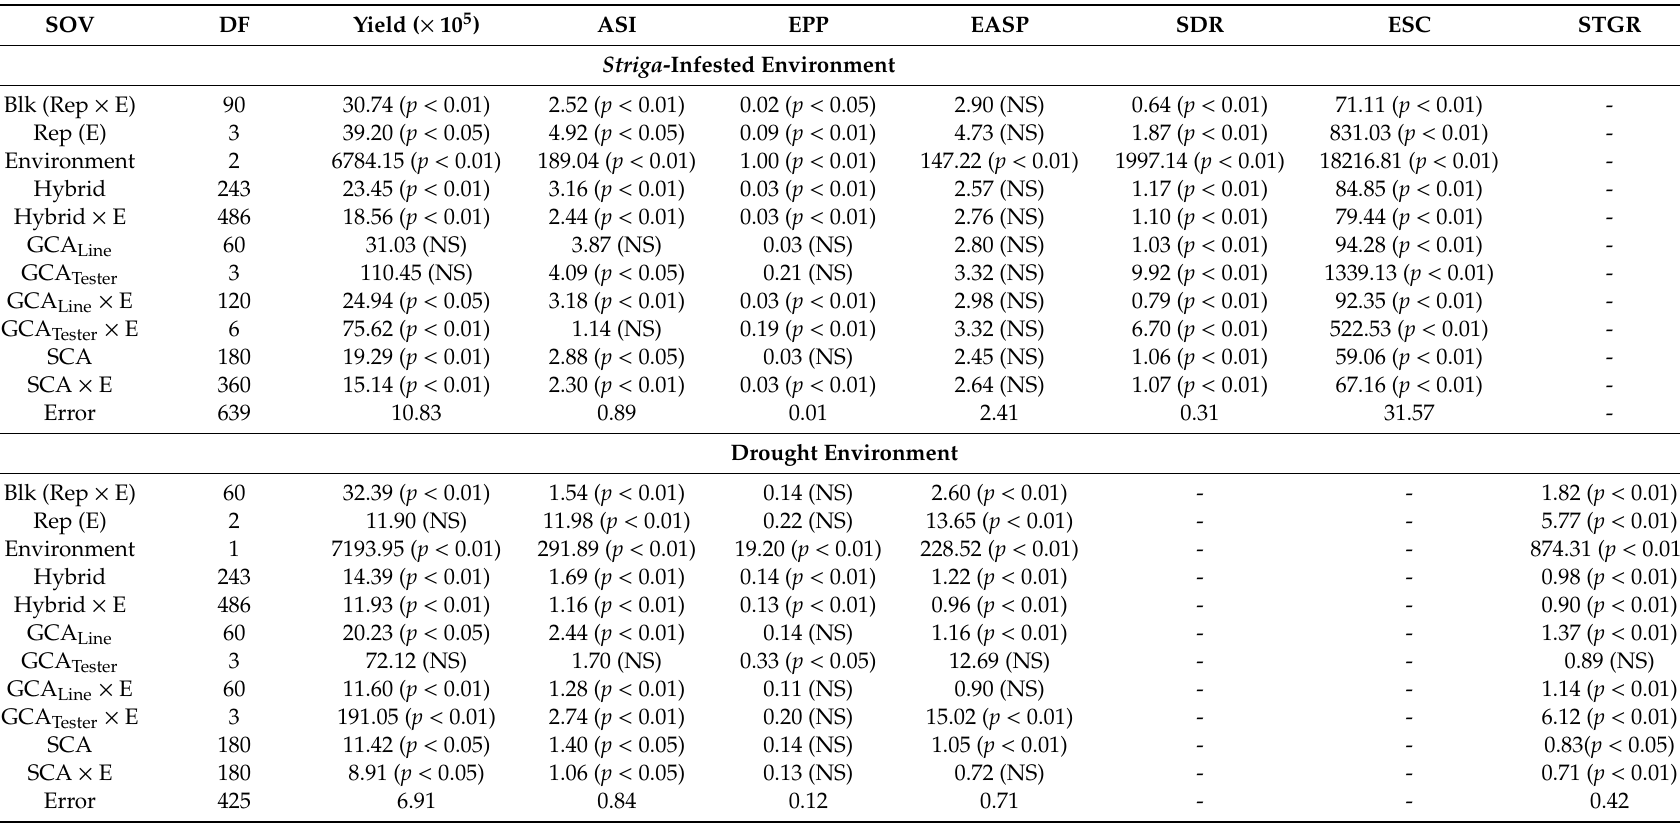
Table 3. Mean squares from the line × tester analysis of variance of maize topcrosses evaluated under Striga -infested and drought